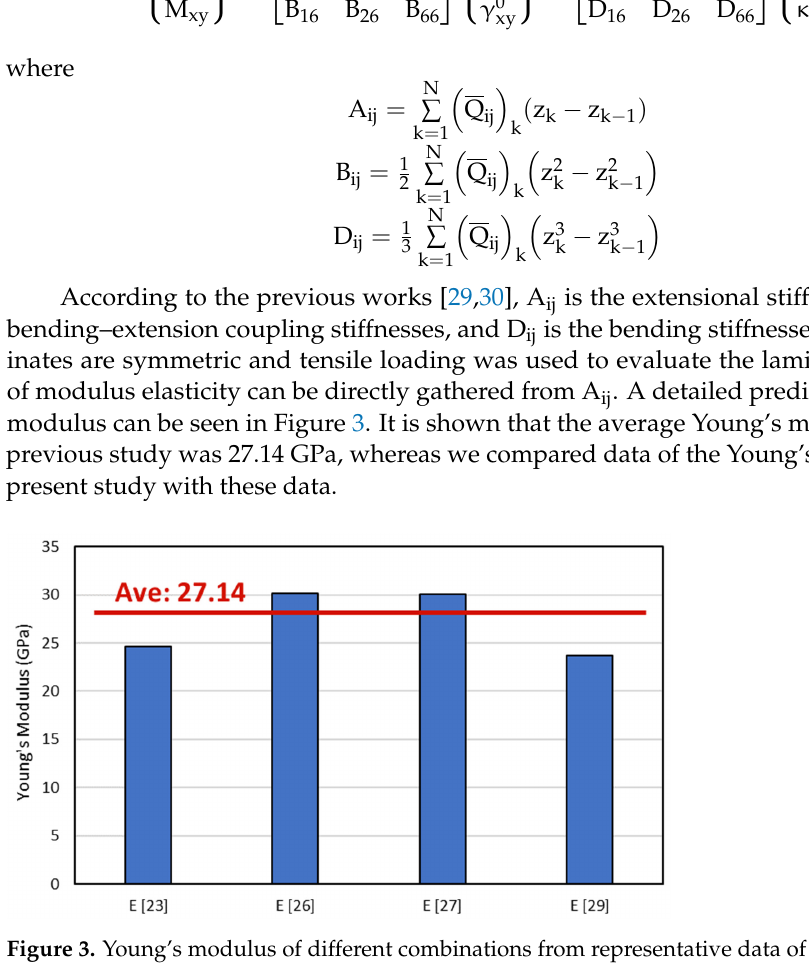
Figure 3. Young's modulus of different combinations from representative data of previous work. Figure 3. Young’s modulus of different combinations from representative data of previous